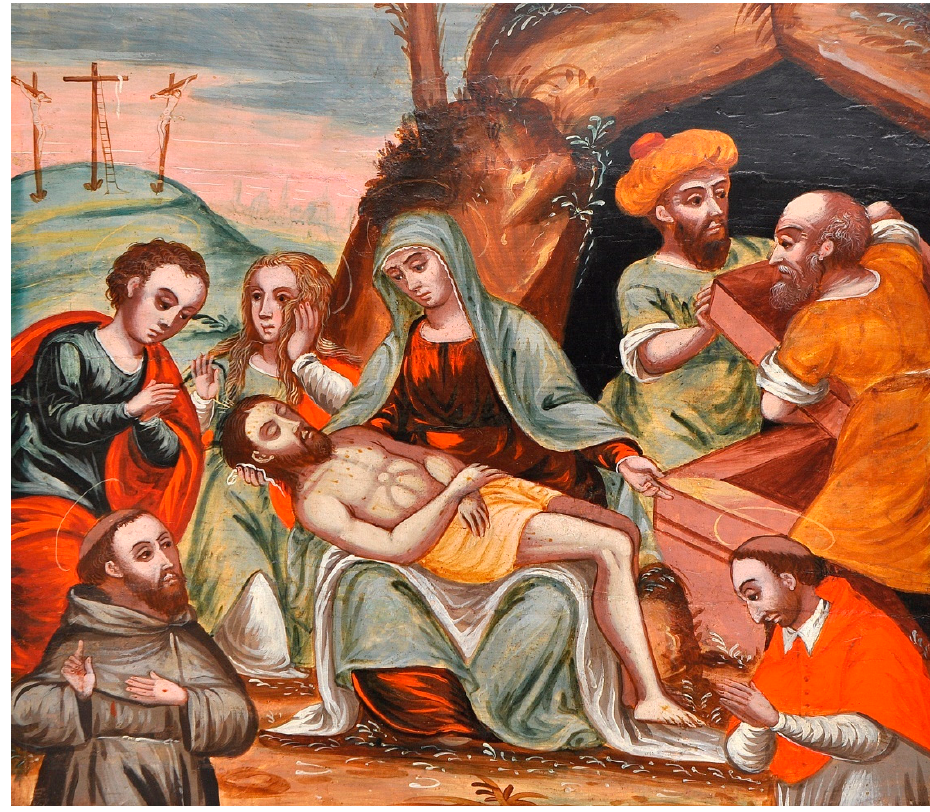
Figure 4. The Deposition (Pietà) with Saints Francis of Assisi and Carlo Borromeo, ca. 1620–1630, © Koper, Pokrajinski Muzej.